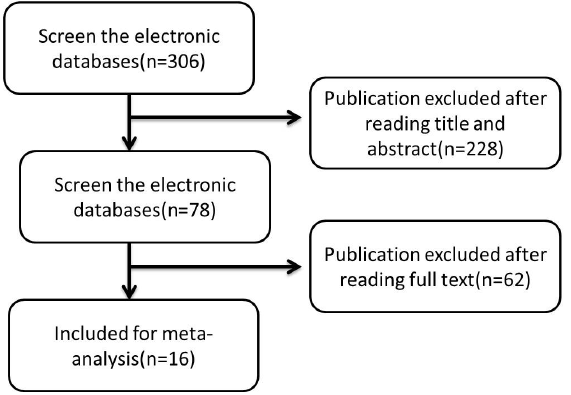
Figure 1: Literature screening process and